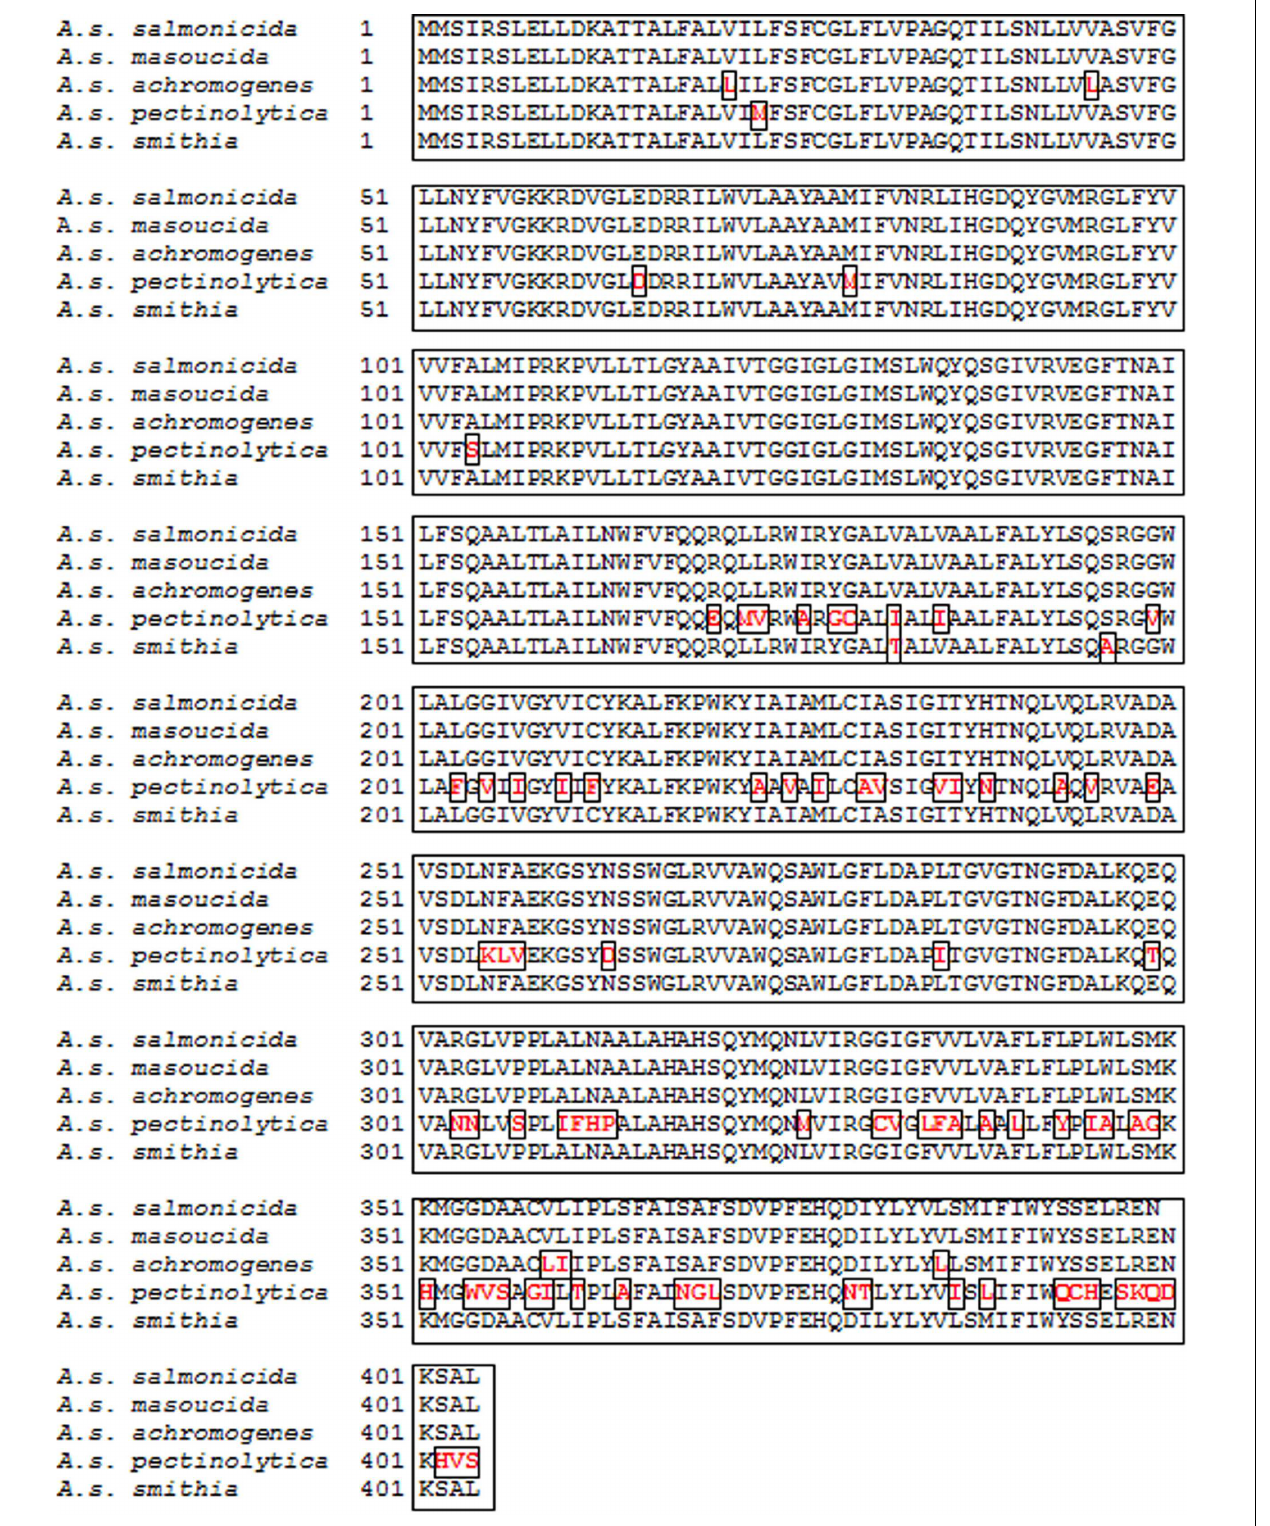
FIGURE 8 | Alignment of the WaaL aminoacid sequence from A. salmonicida subsp. salmonicida A450, A. salmonicida subsp. masoucida NBRC13784, A. salmonicida subsp. achromogenes strain AS03, A. salmonicida subsp. pectinolytica strain 34melT, and A. salmonicida subsp. smithia CECT5179. Different aminoacids residues among the sequences are labeled in red and bold and inside a square box.